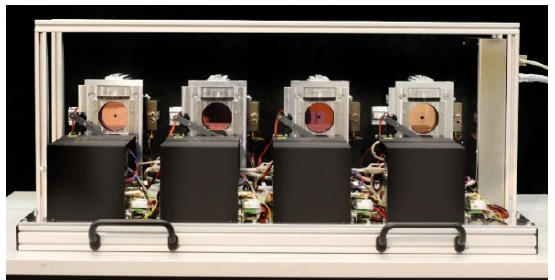
Figure 6. Practical set-up of the fan-shaped distance meter system with four distance meters on a